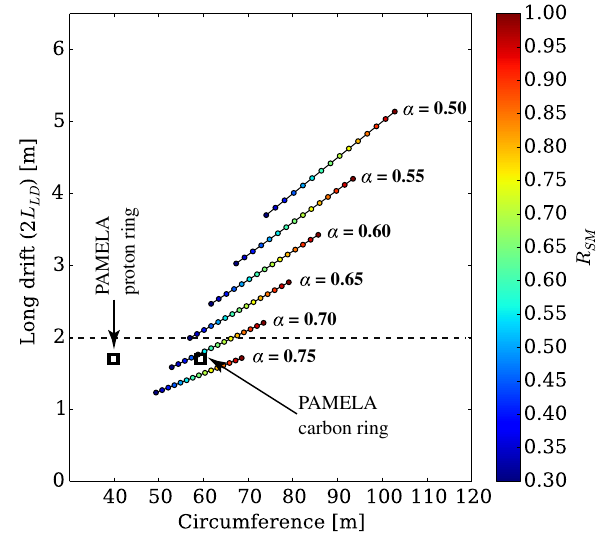
FIG. 2. Stable 10 cell ring lattices using optimization in P y Z goubi in the geometric parameter space. The color of each point indicates the ratio R SM . The location of the PAMELA proton and carbon rings are shown in the parameter space for comparison. The dashed line at 2 L LD ¼ 2 . 0 m indicates our requirement limit for the long drift between magnets in neighbor- ing cells. The lattice becomes unstable when increasing α above 0.75 and reducing R SM below 0.3. at the fixed working point at Q ¼ 7 . 7 , Q ¼ 2 . 7 h v